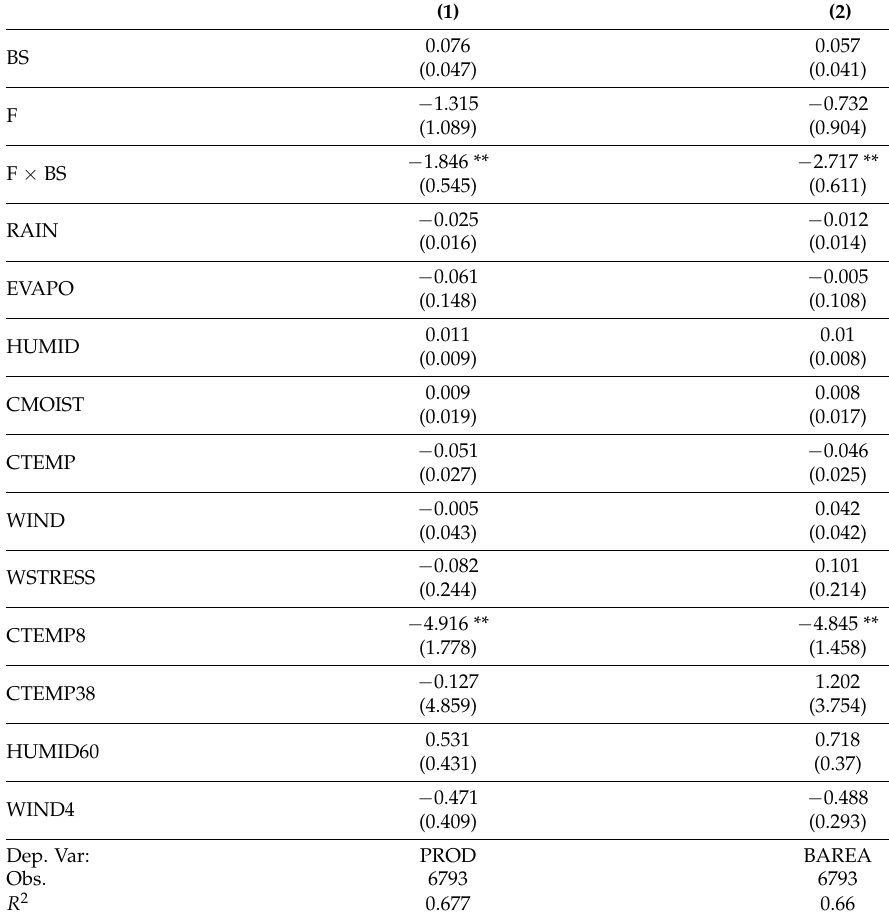
Table 3. Banana Production.